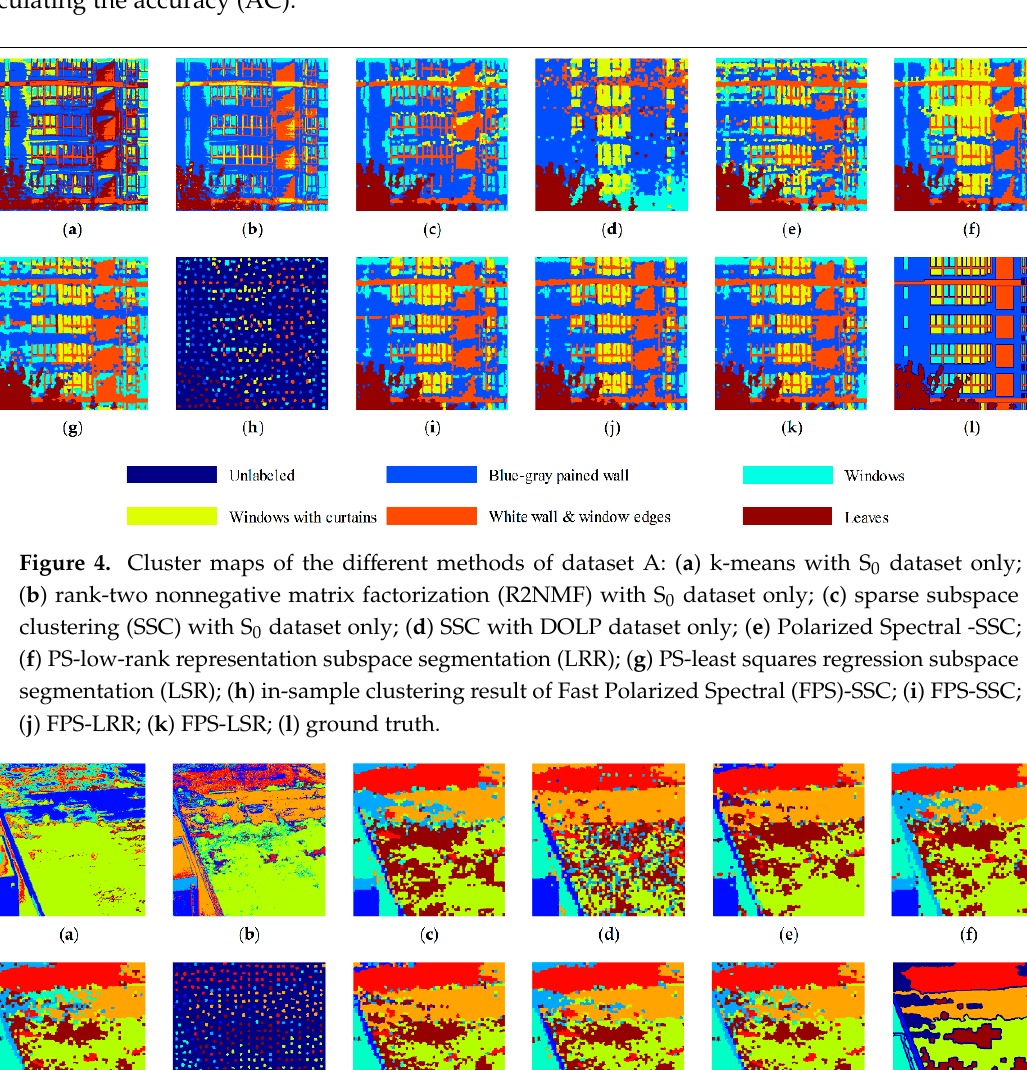
Figure 5. Cluster maps of the different methods of dataset B: ( a ) k-means with S 0 dataset only; ( b ) R2NMF with S 0 dataset only; ( c ) SSC with S 0 dataset only; ( d ) SSC with DOLP dataset only; ( e ) PS- SSC; ( f ) PS-LRR; ( g ) PS-LSR; ( h ) in-sample clustering result of FPS-SSC; ( i ) FPS-SSC; ( j ) FPS-LRR; ( k ) FPS-LSR; ( l ) ground truth.